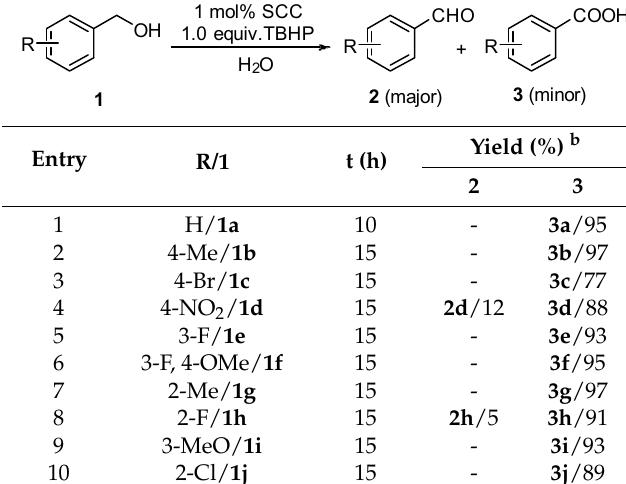
Table 3. The oxidation of benzyl alcohol catalyzed by SCC a . Table 2. The oxidation of benzyl alcohol catalyzed by sodium copper chlorophyllin (SCC) a .